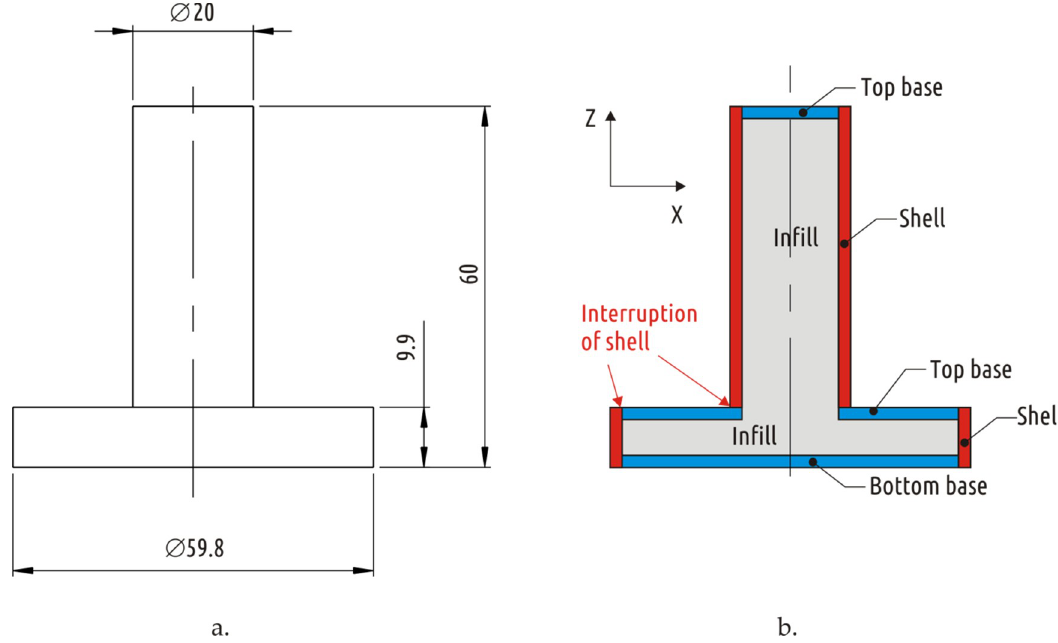
Figure 2. Shape 1 dimensions ( a ) and constitution ( b ) with shell interruption highlighted .